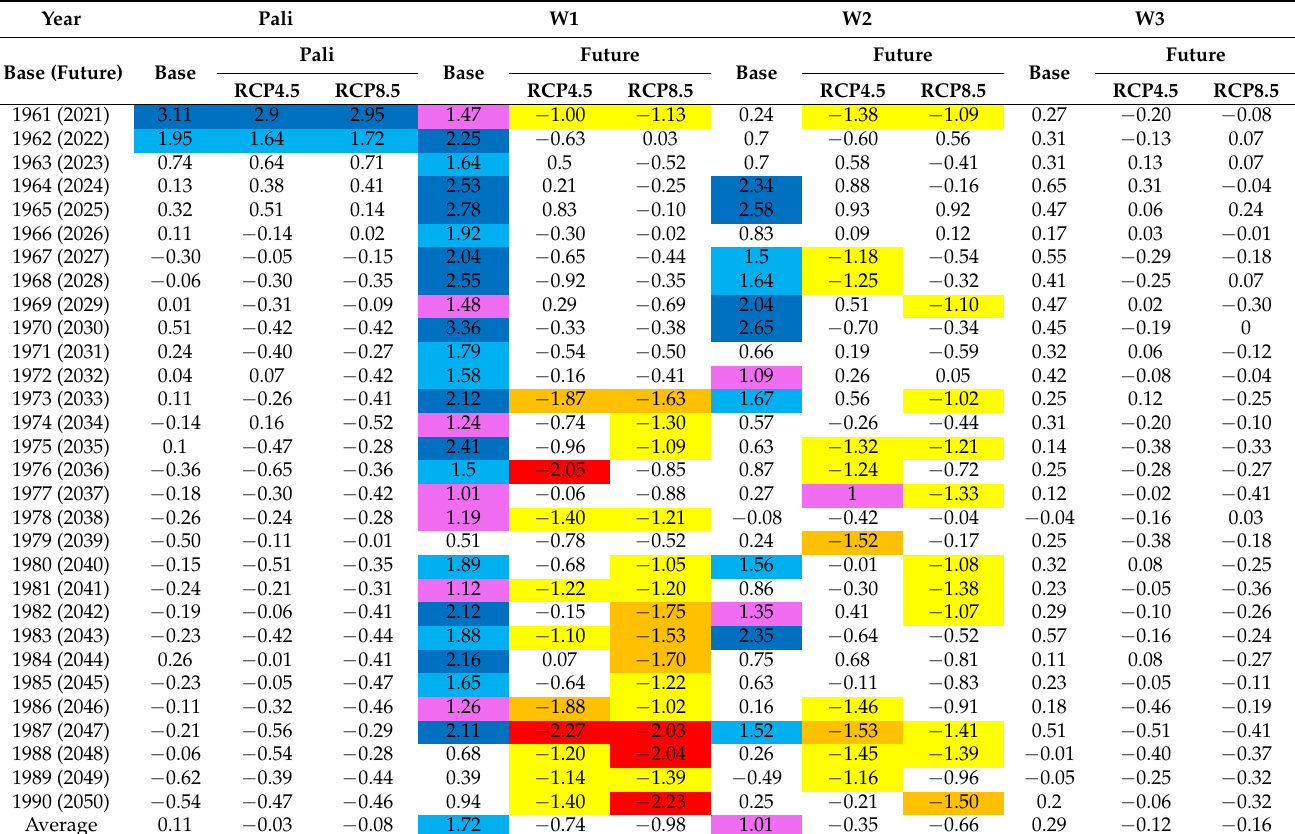
Table 4. The SGLDI values of the Pali alluvial aquifer and the karst wells (W1, W2 and W3) in the base and future time periods, considering RCP4.5 and RCP8.5 (uncolored cells indicate